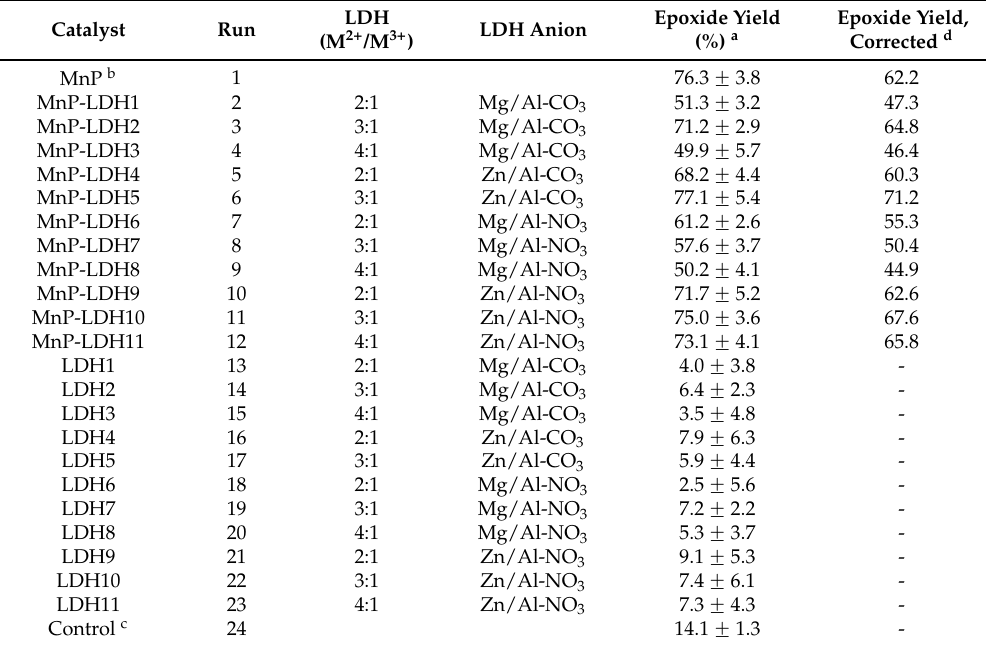
Table 6. Results obtained in the epoxidation reactions cyclooctene.